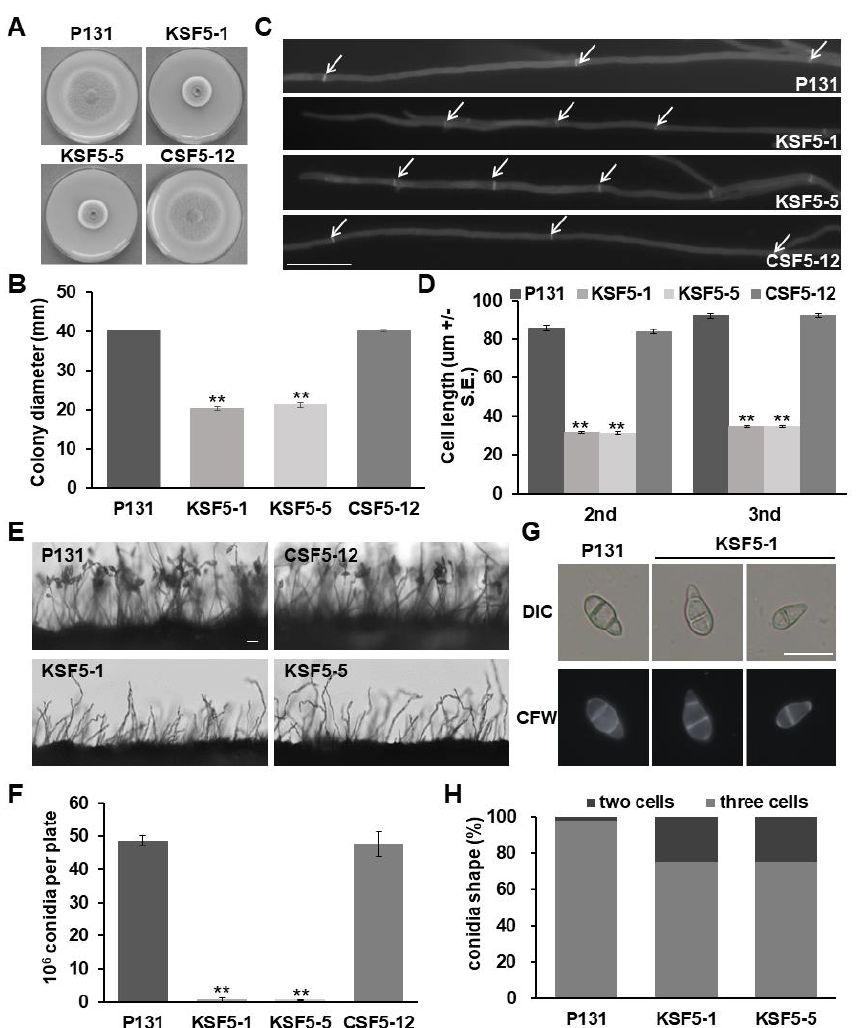
Figure 1. MoSNF5 is required for vegetative hyphal growth and conidiation. ( A ) Colonies of the wild-type strain P131, the Δ Mosnf5 mutants KSF5 − 1 and KSF5−5 , and its one complementation strain CSF5−12 cultured on an OTA plate at 5 dpi. ( B ) Statistics on colony diameters of strains P131, KSF5−1 , KSF5−5 , and CSF5−12 at 5 dpi. The mean and standard deviations were calculated based on three independent experiments by measuring three plates in each replicate. Asterisk marks a significant difference between the mutants and the P131 strain by using t -test ( p < 0.05). ( C ) Vegetative hyphae of strains P131, KSF5−1 , KSF5−5 , and CSF5−12 stained with Calcofluor white. White arrows point to the septa. Bar, 20 μ m. ( D ) The average length of the secondary- and third-apical cells of vegetative hyphae of strains P131, KSF5−1 , KSF5−5 , and CSF5−12 . The means and standard deviations were calculated by measuring 30 mycelia. Asterisk marks a significant difference between the mutants and the P131 strain by using t -test ( p < 0.01). ( E ) Vertical view of conidiation structures at 24 h after induction of conidiation. Bar, 20 μ m. ( F ) Capacity on conidiation of strains P131, KSF5−1 , KSF5−5 , and CSF5−12 . The mean and standard deviations were calculated based on three independent experiments by measuring three plates in each replicate. Asterisk marks a significant difference between the mutants and the P131 strain by using t -test ( p < 0.01). ( G ) Conidium morphology of strains P131 and KSF5−1 stained with Calcofluor white. Bar, 20 μ m. ( H ) Statistics on conidium morphology of strains P131, KSF5−1 , and KSF5−5 . The means were calculated by measuring 100 conidia.